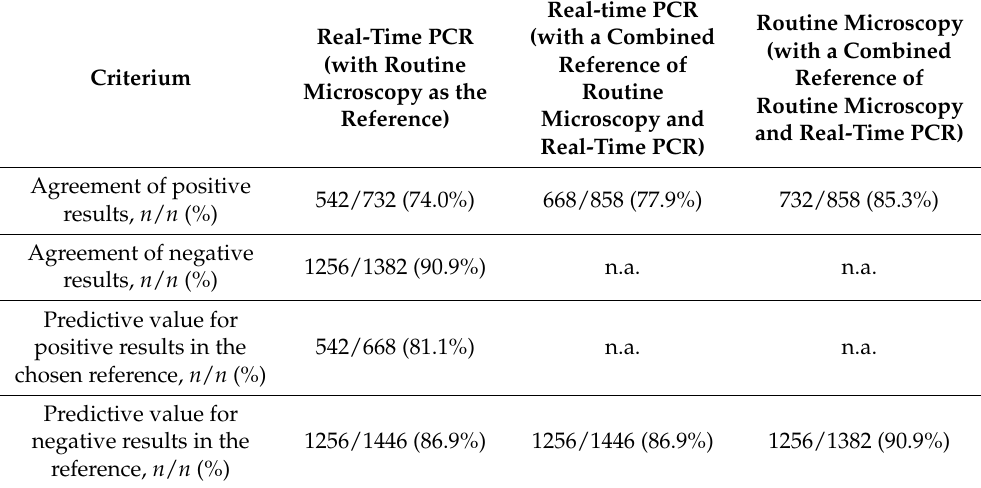
Table 5. Agreement of positive and negative real-time PCR results with routine microscopy as the reference and with a combined reference comprising routine microscopy and real-time PCR regarding malaria detection at the genus level ( n =